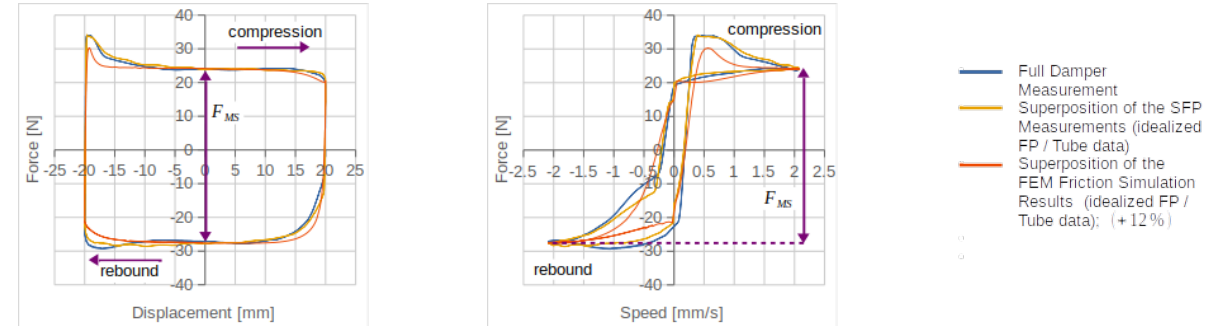
Figure 10. Comparison of the force displacement graphs ( left ) and the force speed graphs ( right ) of the full take-apart damper friction measurement, the superposition of the SFP measurements, and the super-positioned FEM friction simu- lation results; floating piston/tube friction contribution with regard to Equation (3).